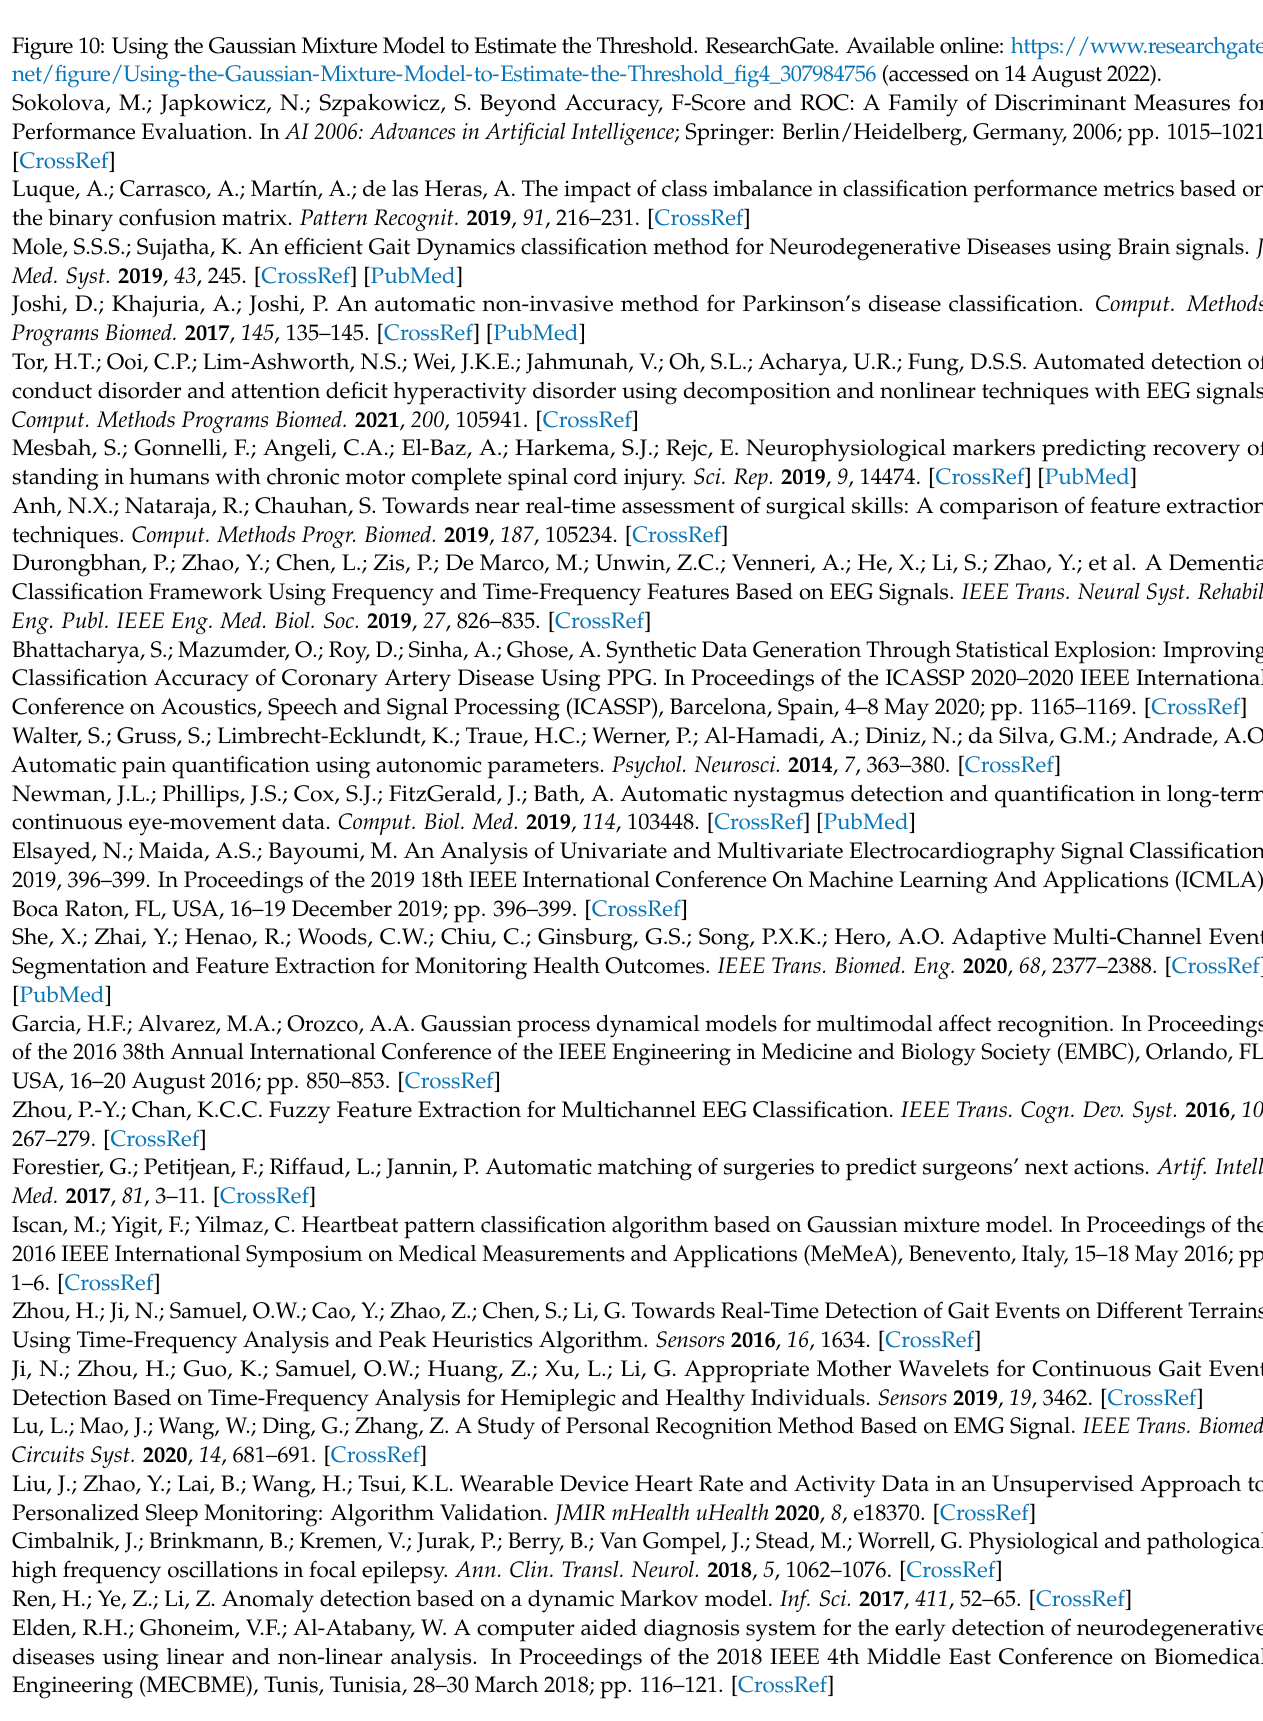
Figure 10: Using the Gaussian Mixture Model to Estimate the Threshold. ResearchGate. Available online: https://www.researchgate. net/figure/Using-the-Gaussian-Mixture-Model-to-Estimate-the-Threshold_fig4_307984756 (accessed on 14 August